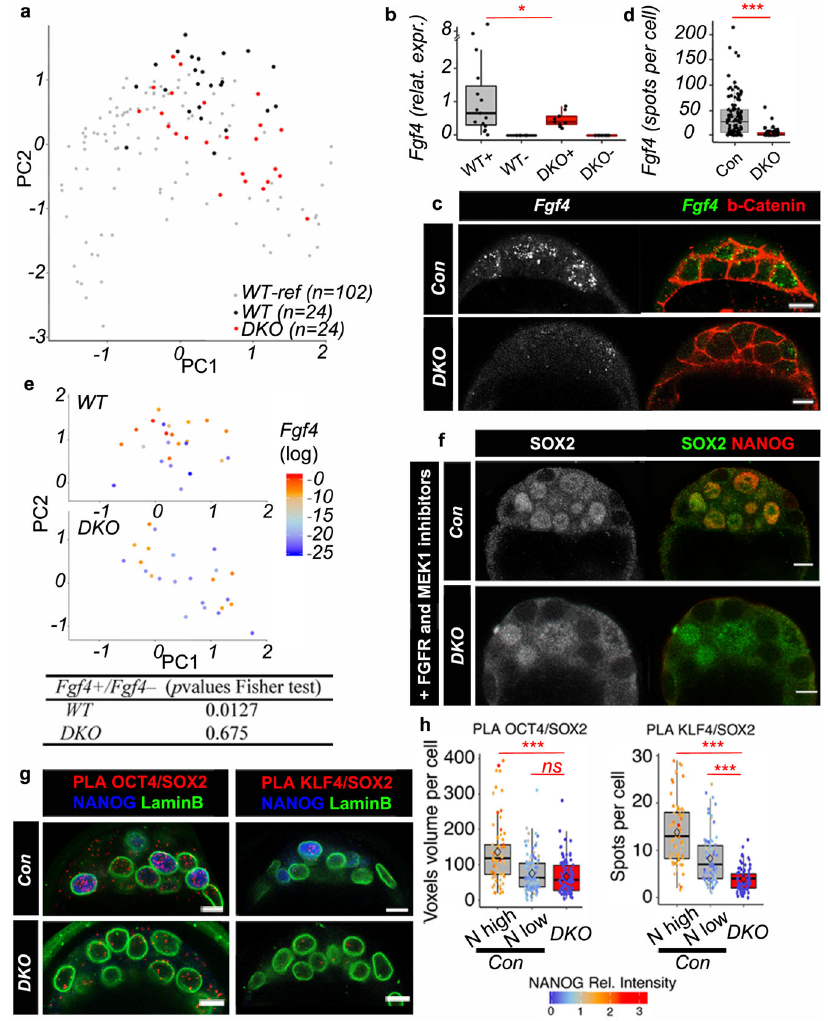
Fig. 3 Cell heterogeneity in DKO ICMs. a PCA performed with DKO and WT cells (32 – 50C) and with WT cells from Fig. 1a, b (16C, 32C, 64C and 90C) as reference ( WT -Ref) (scores: PC1, 20.84%; PC2, 13.13%). b Boxplot showing Fgf4 expression levels in Fgf4 + and Fgf4 − populations ( + and − ) in WT ( n = 4 embryos) (15 cells Fgf4 + and 9 cells Fgf4-) and DKO ( n = 4) (9 cells Fgf4 + and 15 cells Fgf4 − ); Fligner-Killeen test for homogeneity of variance (between WT and DKO Fgf4 + cells p value = 0.012. c Representative images of Fgf4 HCR RNA-FISH, coupled with b-Catenin IF, in 64C DKO ( n = 4) and control embryos. Scale bars: 10 µ m. d Quanti fi cation of HCR RNA-FISH spots in ICM cells from control ( n = 115 cells from 7 embryos) and DKO ( n = 77 cells